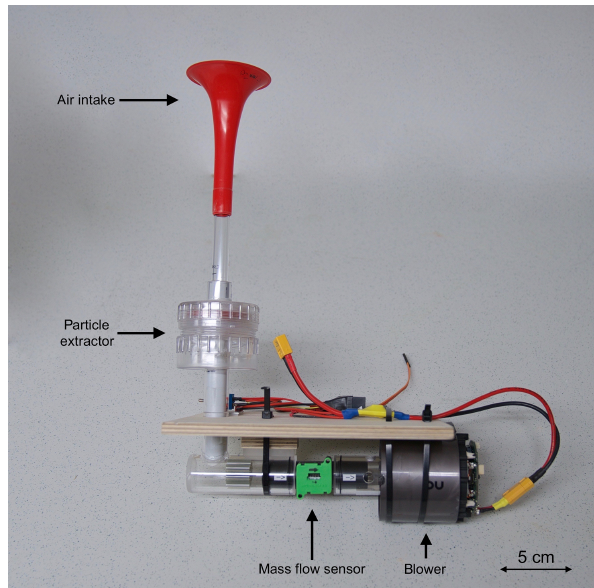
Figure 2. Newly developed particle collection system (PCS) with a complete weight of 600g comprising (1) an air inlet that al- lows the intake of ambient air under near-isokinetic conditions, (2) an impactor for extracting the particles from sampled air and depositing them on a sample carrier, (3) a mass flow sensor located downstream of the particle extractor, measuring the air mass flow through the PCS, and (4) an electric blower generating the airflow through the components of the PCS. The components of the PCS and their connections are airtight. Air volume flow during operation is 200Lmin − 1